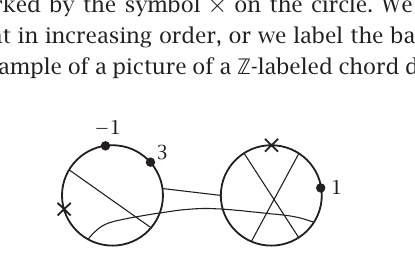
Figure 7.1 . A picture of a Z -labeled chord